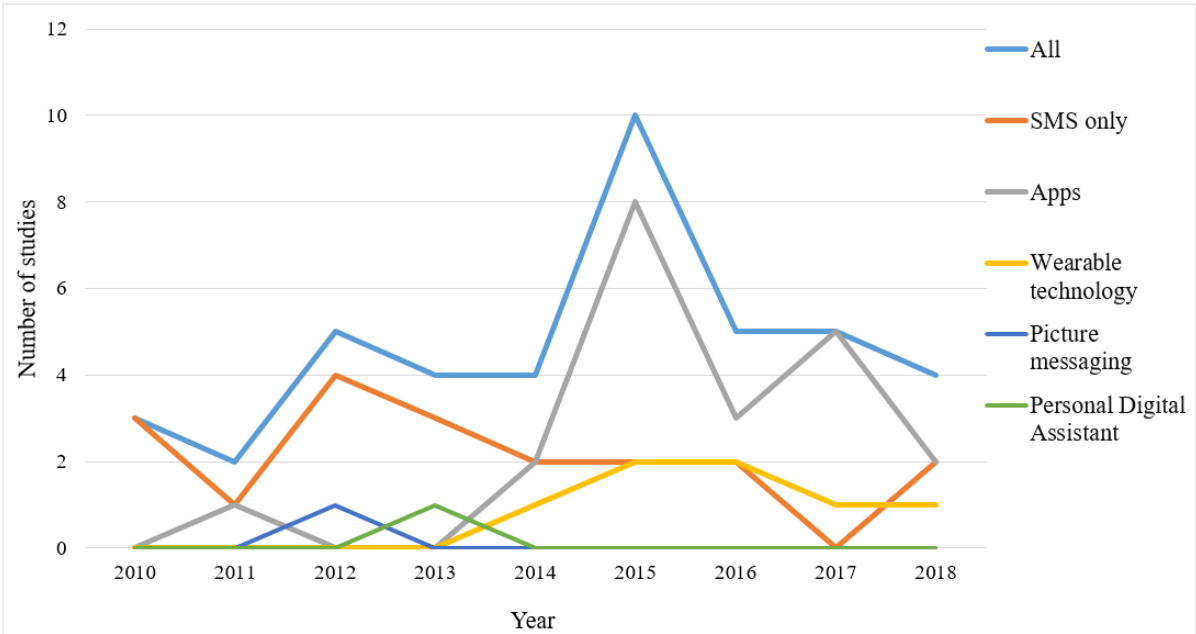
Figure 2. Number of eligible studies by year and mode of